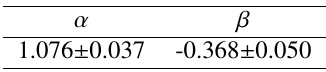
Table 1. Regression fit parameters for the ODS log-log data: